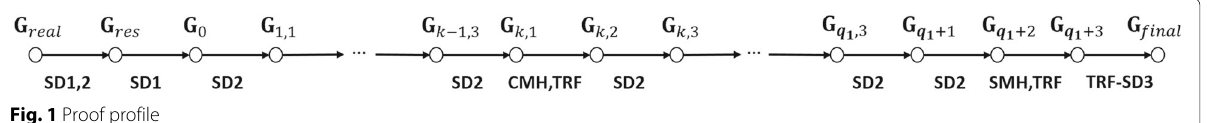
Fig. 1 Proof profile